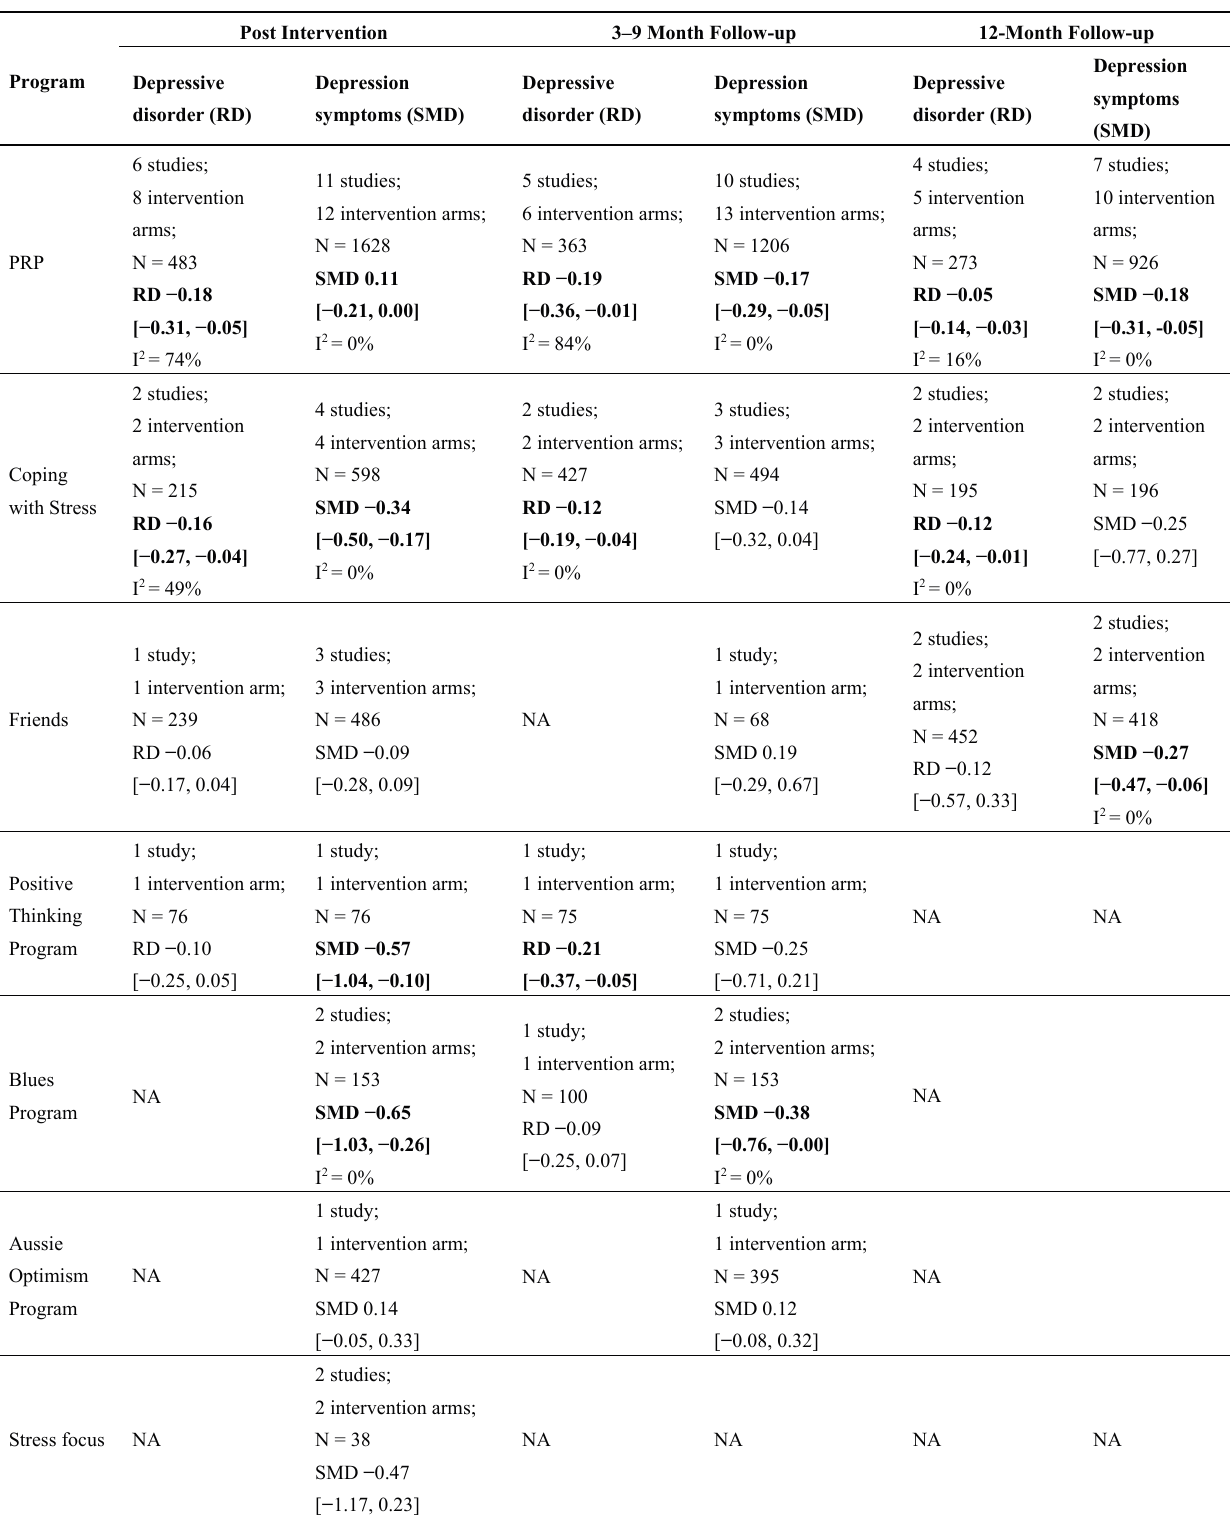
Table 4. Summary of meta-analysis results for named